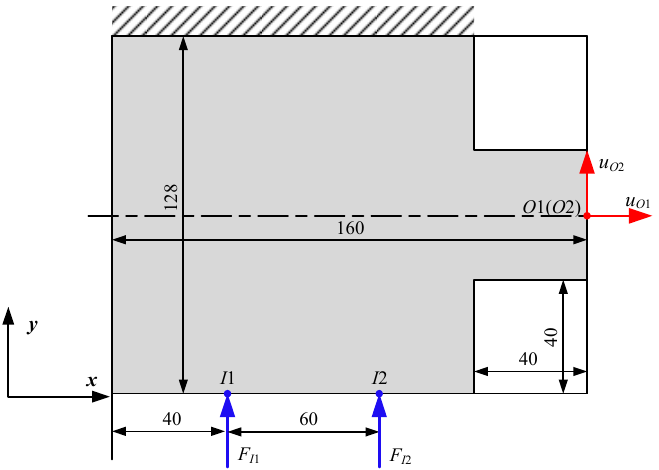
Figure 4. Design domain and boundary conditions of the compliant path generator.